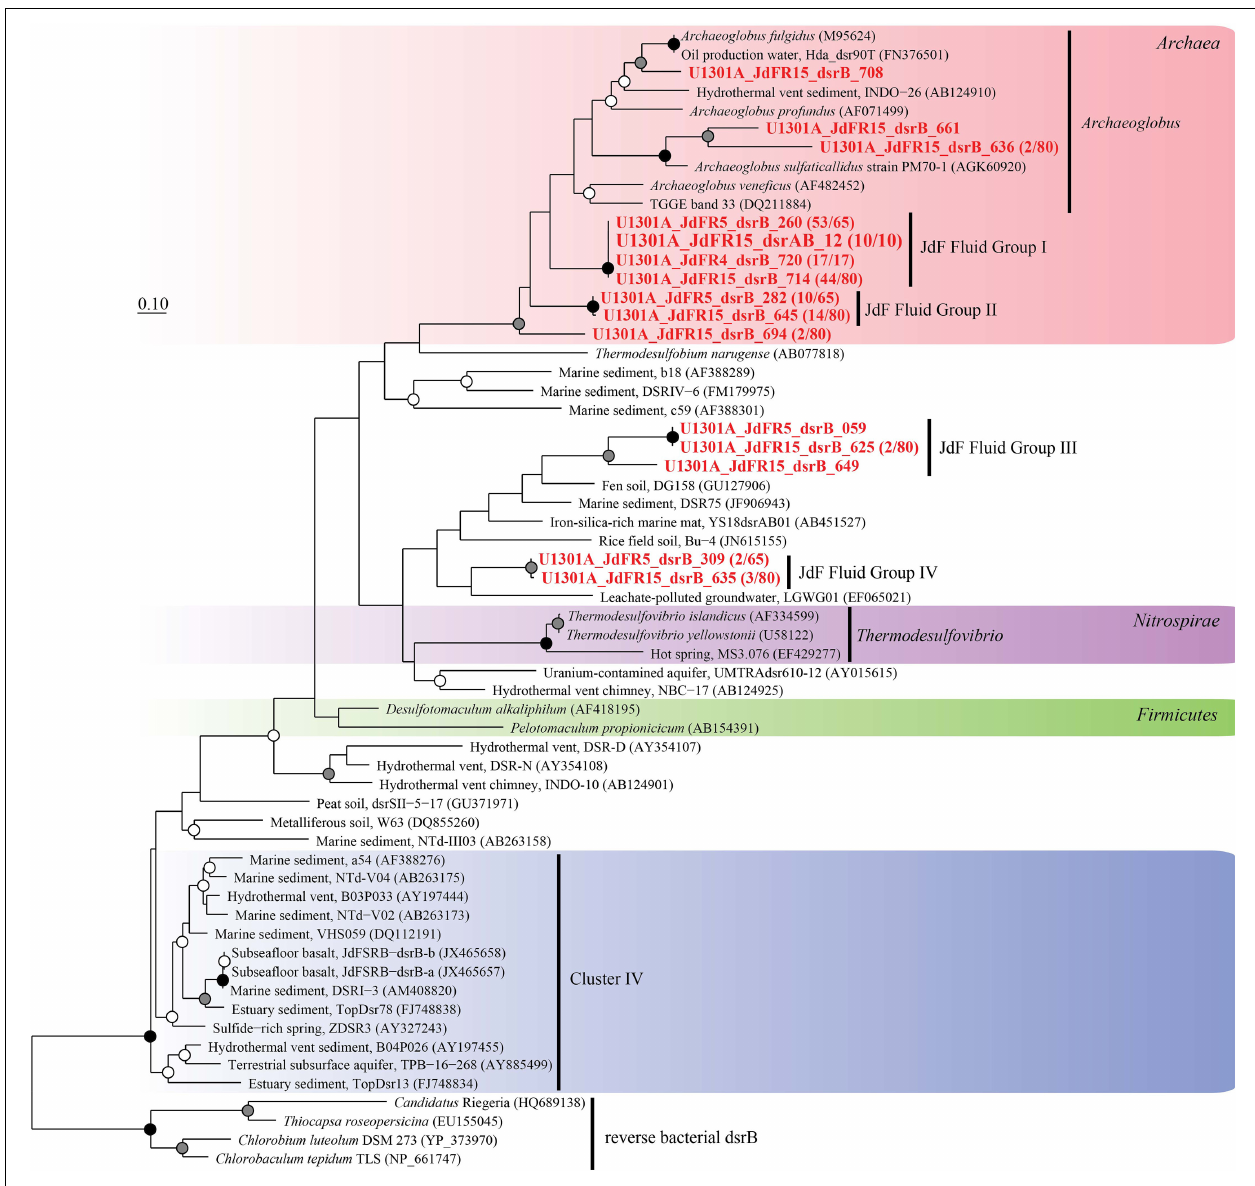
FIGURE 7 | Phylogenetic relationships of borehole fluid dsrB fragments from the domain Archaea and uncultivated lineages. Gene clones recovered in this study are highlighted in bold font; the fractional abundance of identical clones recovered from the